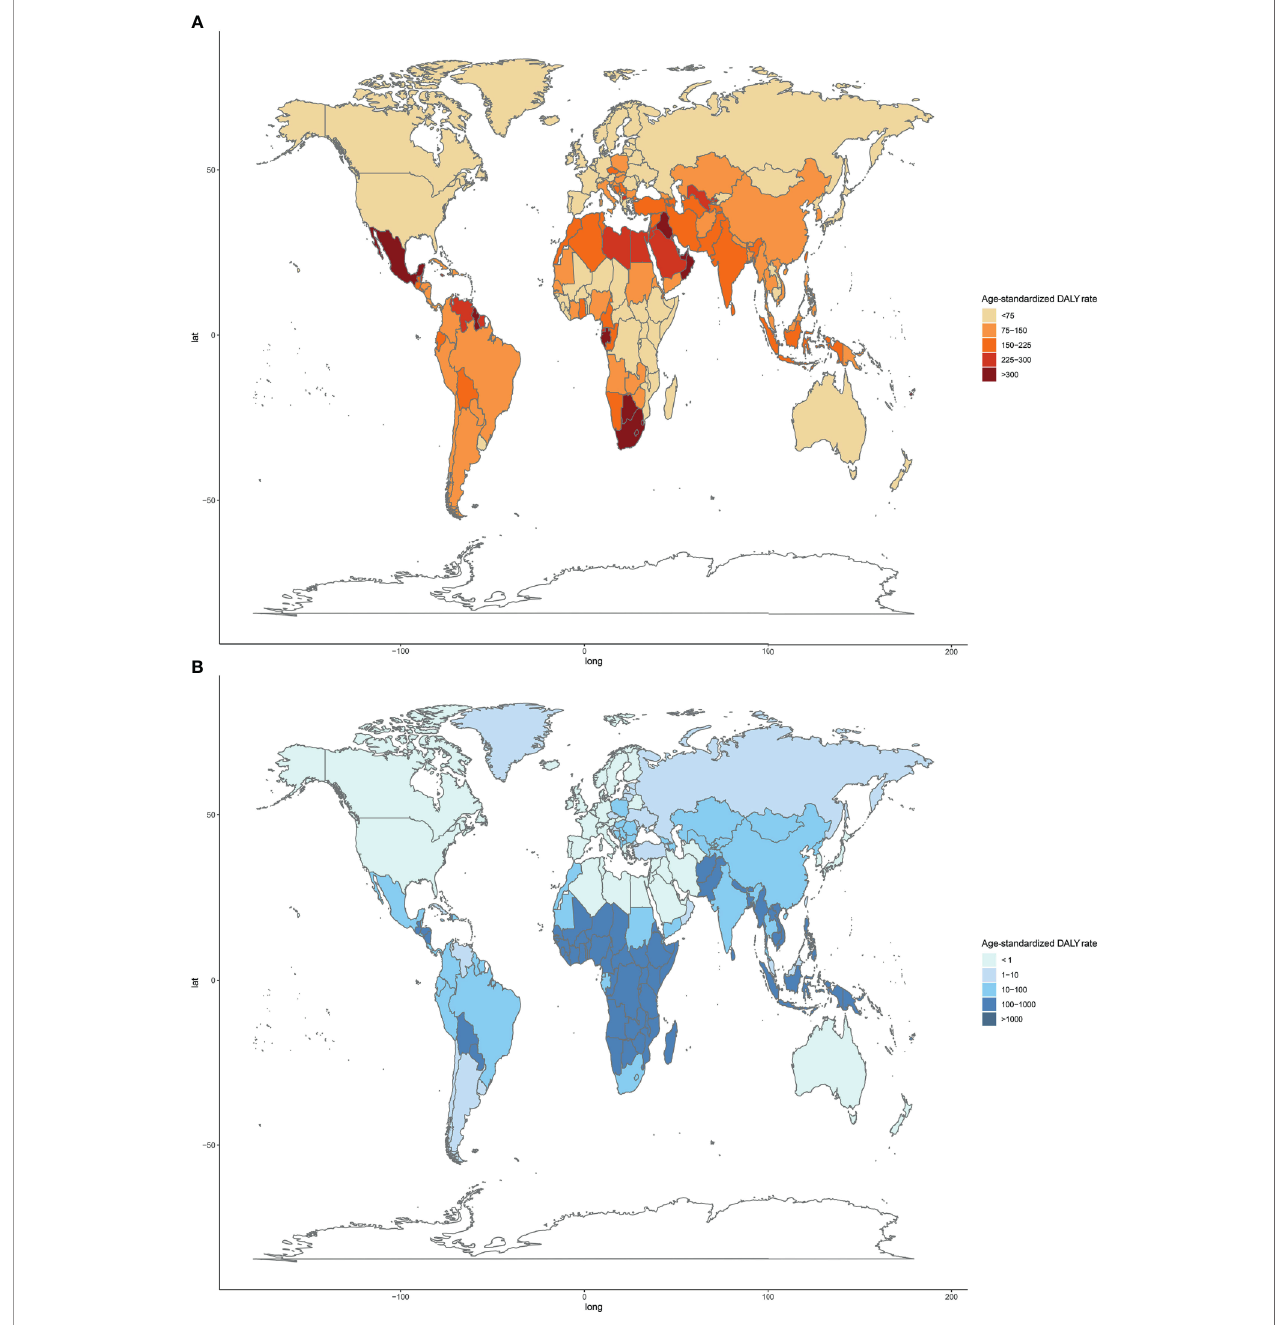
FIGURE 4 | Age-standardized DALY rates of type 2 diabetes mellitus attributable to particulate matter pollution among 204 countries and territories in 2019. (A) APMP; (B) HAP. DALY, disease-adjusted life-year; APMP, ambient particulate matter pollution; HAP, household air